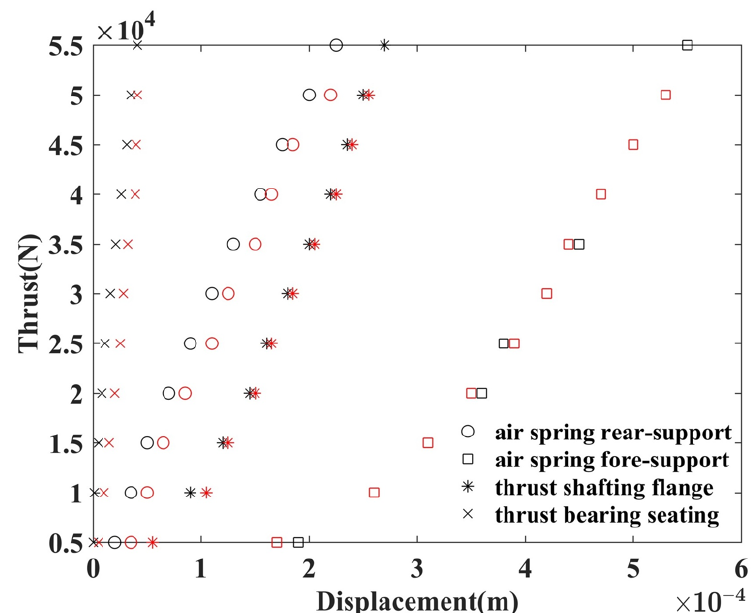
Figure 5. Static thrust-displacement.